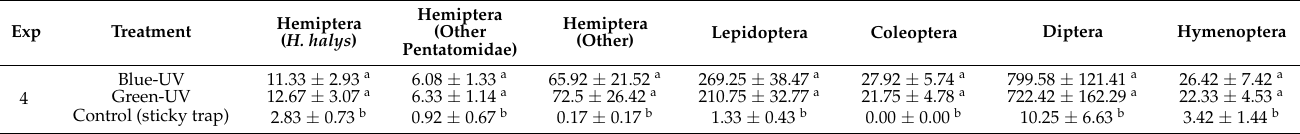
Table 3. Captures (mean ± SE) of H. halys and other main insect groups in multimodal and control traps (Exp. 4). Means in the same column followed by different letters are significantly different according to linear model or linear mixed-effects models followed by multiple comparisons procedure (significance level α = 0.05).